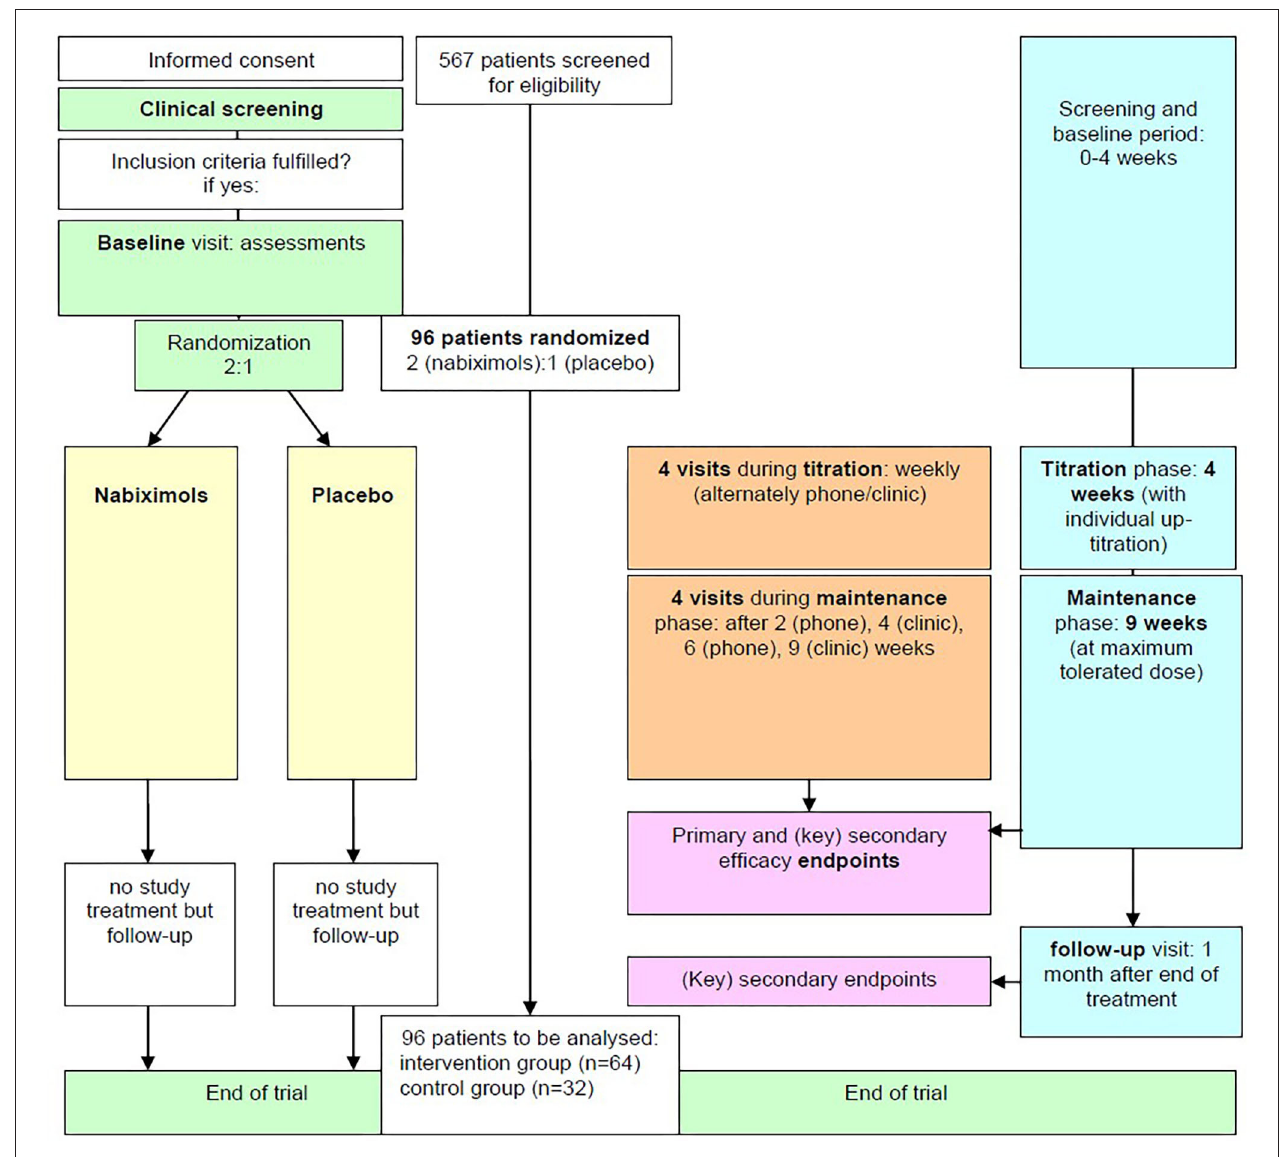
FIGURE 1 | Study Flow. MS,